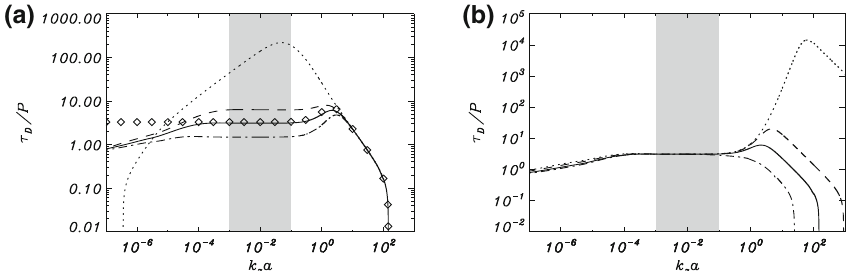
Fig. 74 Wave damping by resonant absorption and ion-neutral effects in an infinitely long cylindrical prominence thread. Ratio of the damping time to the period of the kink mode as a function of k z a for a thread with an inhomogeneous transitional layer. a Results for ˜ μ p = 0 . 8 and different transitional layer widths: l / a = 0 (dotted line), l / a = 0 . 1 (dashed line), l / a = 0 . 2 (solid line) and l / a = 0 . 4 (dash-dotted line). Symbols are the solution in the thin boundary approximation (Eq. 40) for l / a = 0 . 2. b Results for l / a = 0 . 2 and different ionisation degrees: ˜ μ p = 0 . 5 (dotted line), ˜ μ p = 0 . 6 (dashed line), ˜ μ p = 0 . 8 (solid line) and ˜ μ p = 0 . 95 (dash-dotted line). In both panels a = 100 km. Image reproduced with permission from Soler et al. (2009d), copyright by AAS